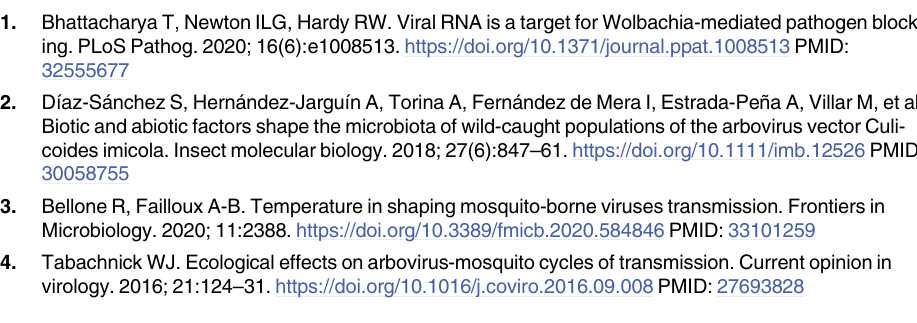
S1 Table. Primers used in this study. Primers were purchased from Integrated DNA Tech- nologies (IDT). All primers were used at a final concentration of 10 μ M for quantitative PCR and RT-PCR reactions. Recommended primer concentrations according to manufacturer’s protocol were used for cloning